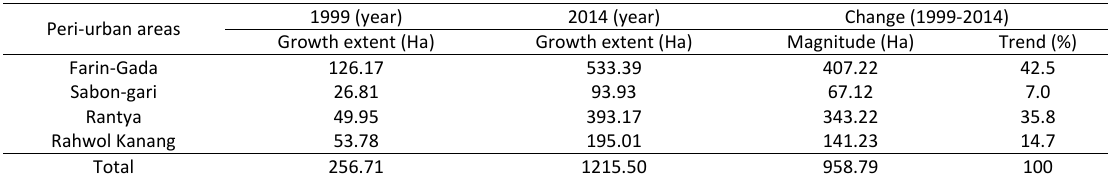
Table 5: Spatial growth of the study area from 1999 to 2014